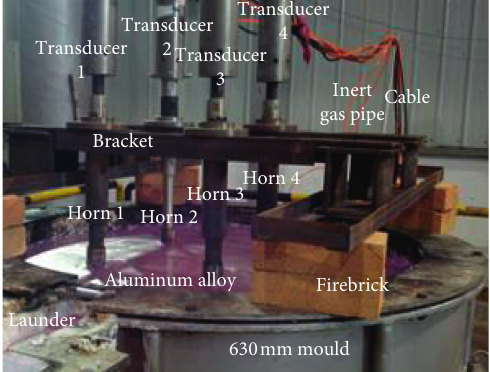
Figure 11: Distribution of traditional four-unit ultrasonic vibra- tion